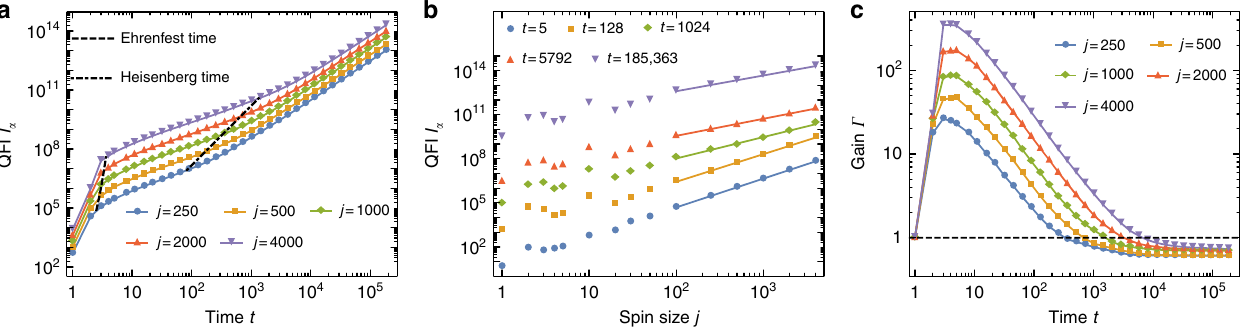
Fig. 2 Quantum-chaotic enhancement of sensitivity. a t -scaling of the quantum Fisher information (QFI) I α in the strongly chaotic case. Dashed and dash- dotted lines indicate Ehrenfest and Heisenberg times, respectively. b j -scaling of the QFI. Fits have slopes 1.96, 1.88, 1.46, 1.16, and 1.08 in increasing order of t . c Gain Γ = I α ,KT / I top,CS as function of time t for different values of spin size j . The dashed black line marks the threshold Γ = 1. Kicking strength k = 30, and initial coherent state at ( θ , ϕ ) = ( π /2, π /2) in all plots